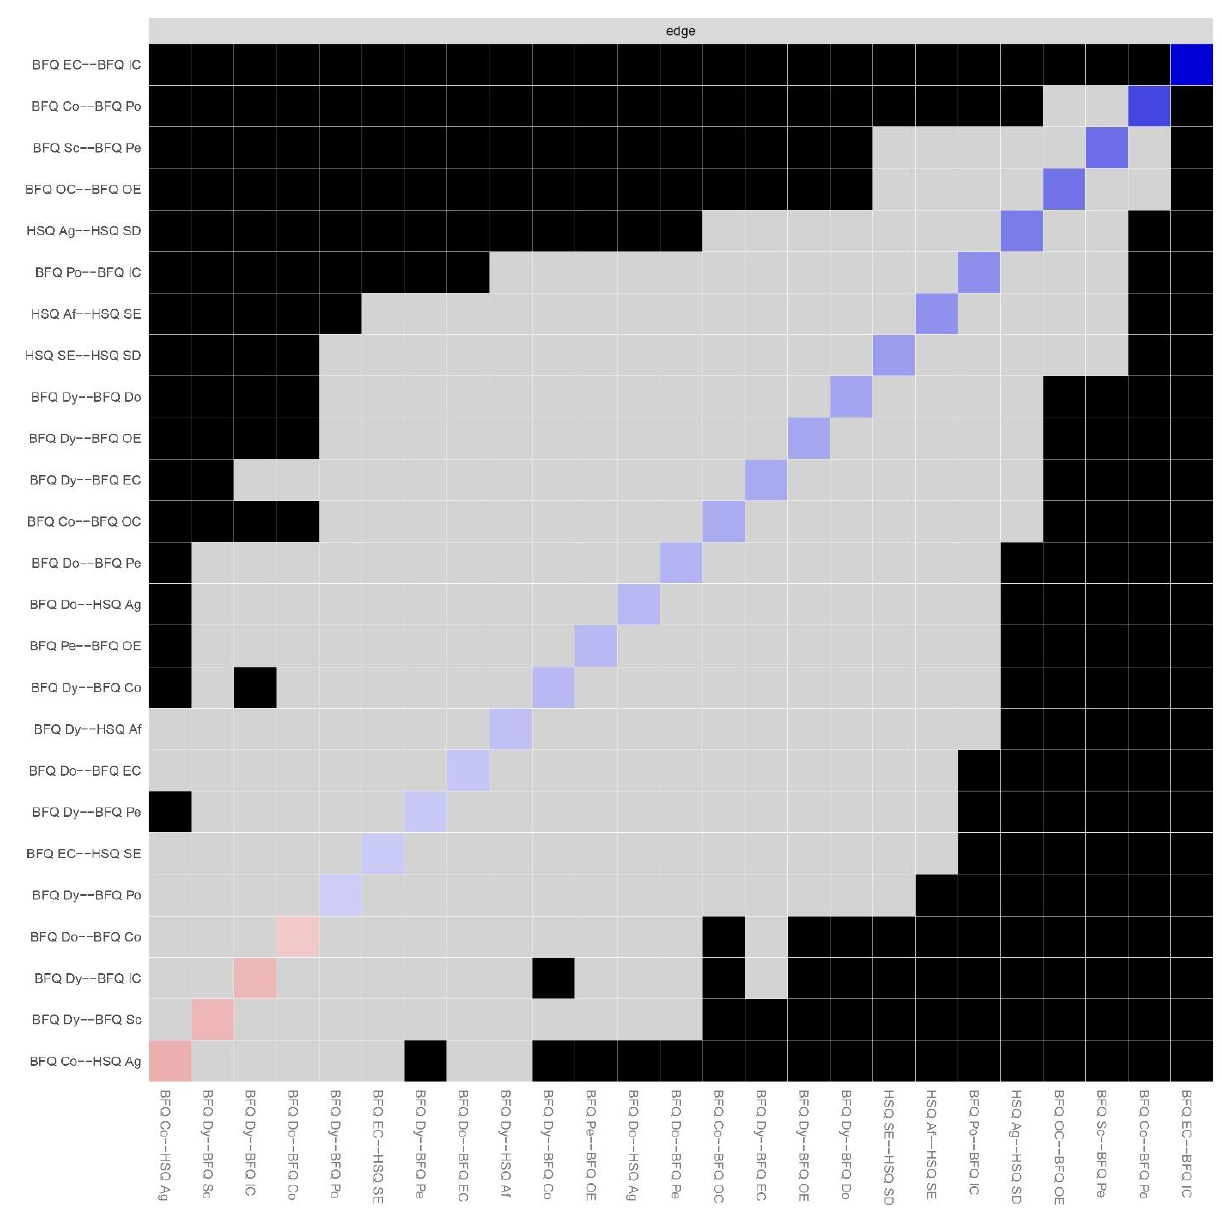
Figure 5. Network of Humor Styles dimensions and Big Five Personality facets: Nonparametric bootstrapped difference test ( n = 462). Note: In ascending order, the X and Y axes indicate all edges in the network with non-zero values. Black boxes represent a statistical difference between two edge weights; gray boxes highlight a difference that is not statistically significant. Blue boxes in the diagonal illustrate positive edges; red boxes illustrate negative edges. A more intense color indicates a stronger edge. On the side of each box, labels display the two nodes connected via the analyzed edge. Big Five Questionnaire (BFQ) ten facets. Dy: Dynamism; Do: Dominance; Co: Cooperativeness; Po: Politeness; Sc: Scrupulousness; Pe: Perseverance; EC: Emotion Control; IC: Impulse Control; OC: Openness to Culture; OE: Openness to Experiences. Humor Style Questionnaire (HSQ) four dimensions. Af: Affiliative; SE: Self-enhancing; Ag: Aggressive; SD: Self-defeating.